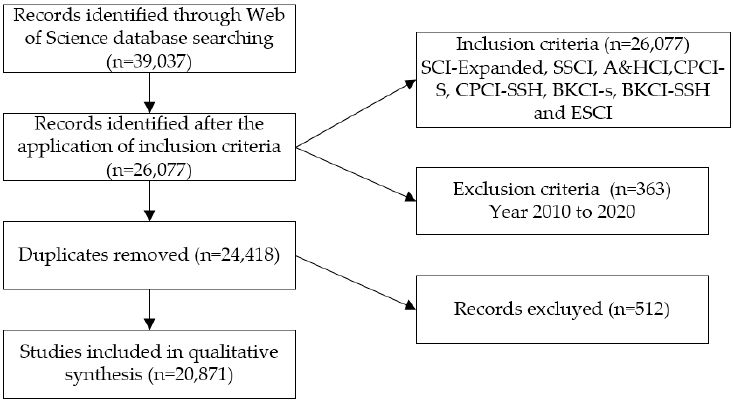
Figure 1. Flowchart according to the PRISMA declaration.